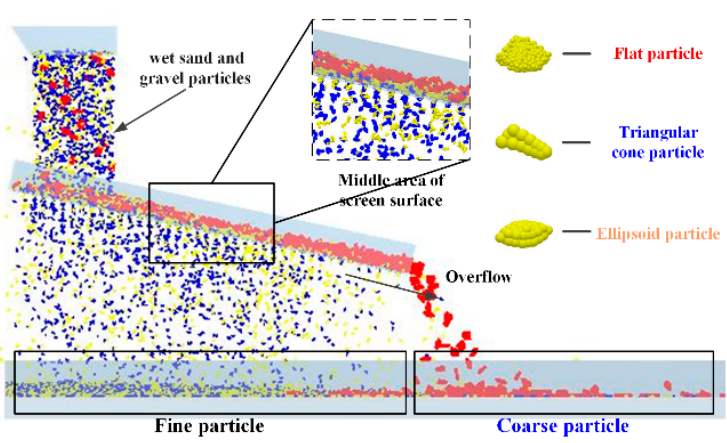
Figure 7. DEM simulation of the vibration screening process.